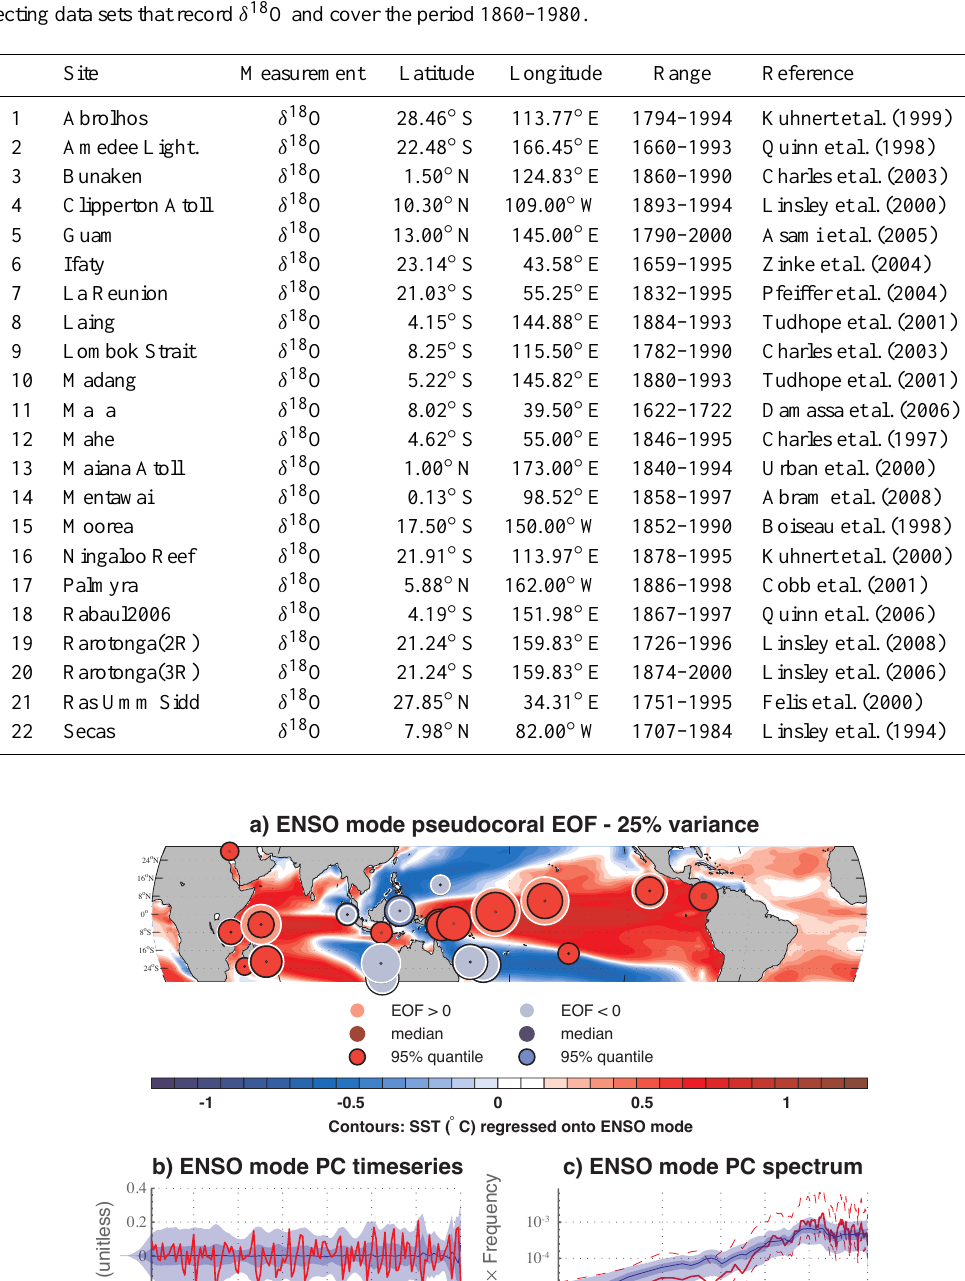
Table 1. List of coral locations used for the EOF analysis of Fig. 5. The records were obtained from the database of Emile-Geay and Eshleman (2013) after selecting data sets that record δ 18 O and cover the period 1860–1980.